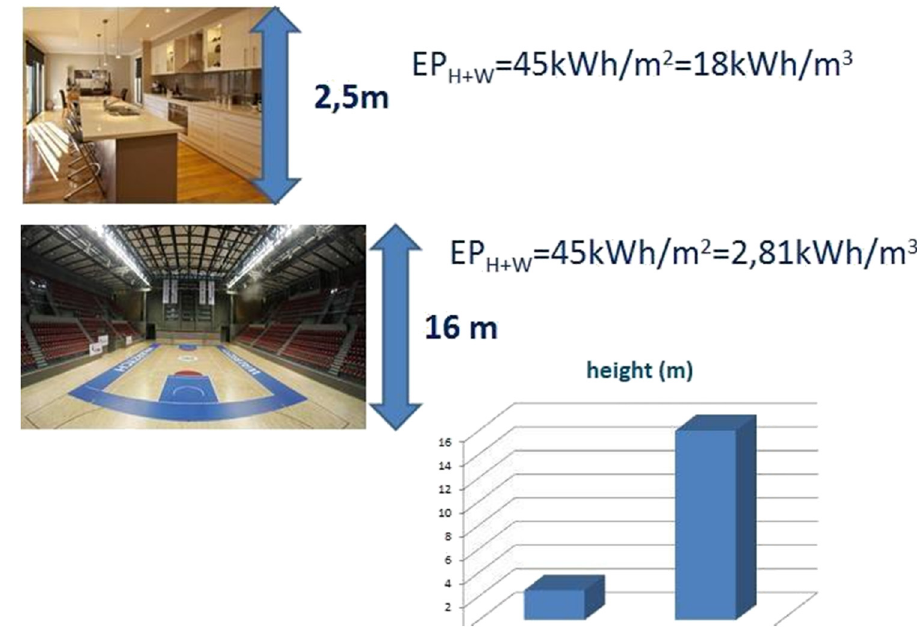
Figure 1: Primary energy limit depending on the height of the building [ 56 ]